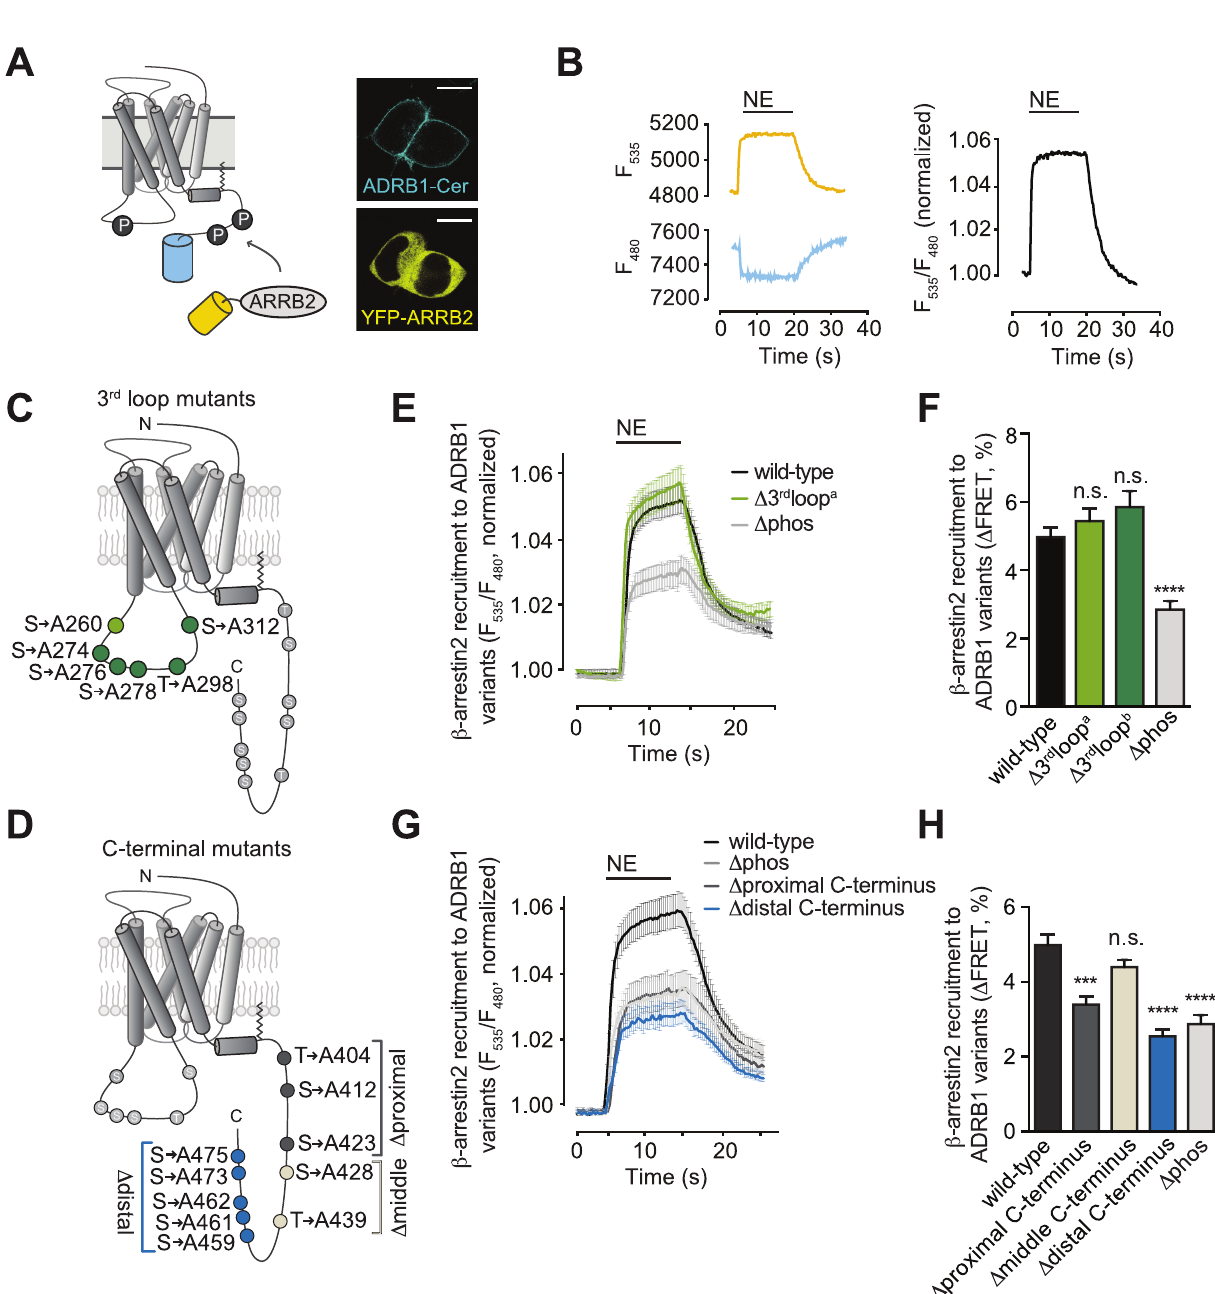
PLOS ONE | https://doi.org/10.1371/journal.pone.0176450 May 4, 2017 8 /